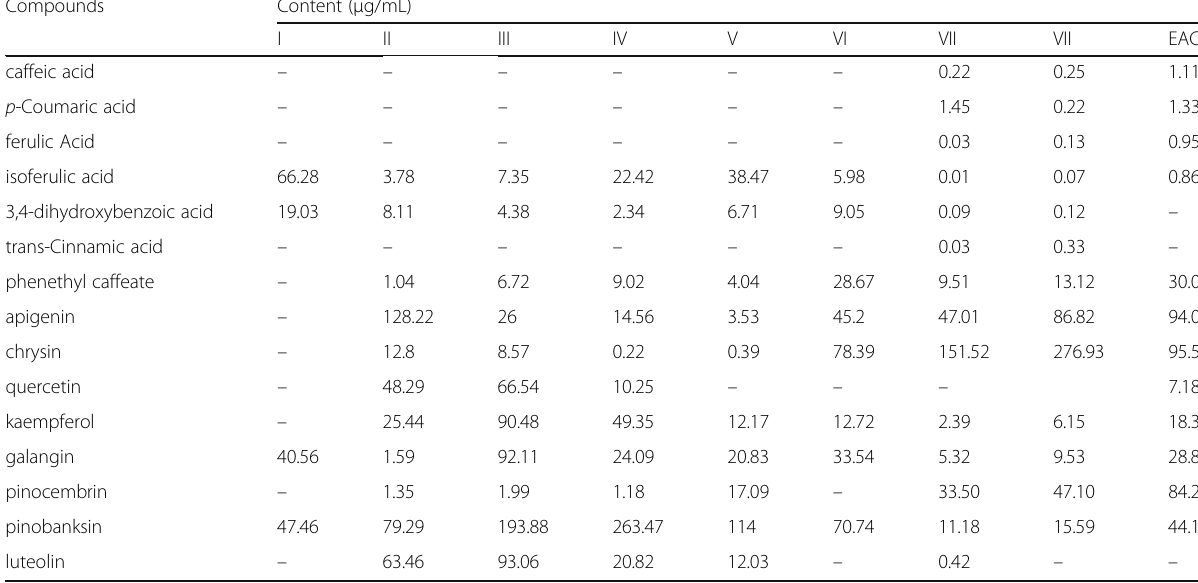
Table 1 HPLC-DAD/Q-TOF-MS analysis on eight subfractions of